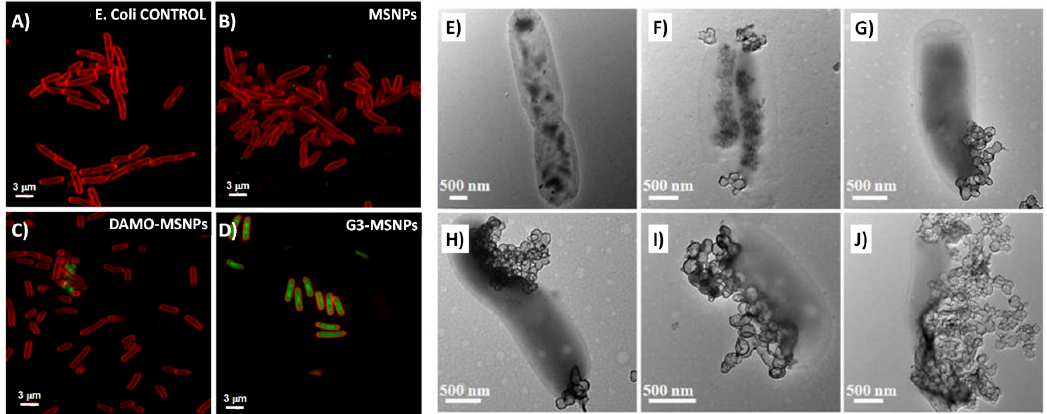
Figure 5. Left side: Confocal microscopy images of E. coli bacteria after treatment with ( A ) media, ( B ) pristine MSNPs, ( C ) N-(2-aminoethyl)-3-aminopropyltrimethoxysilane (DAMO)-MSNPs, and ( D ) G3-MSNPs at 10 mg/mL with an incubation time of 90 min. The E. coli cell membrane was stained with FM4-64FX (red), and the MSNPs were previously functionalized with